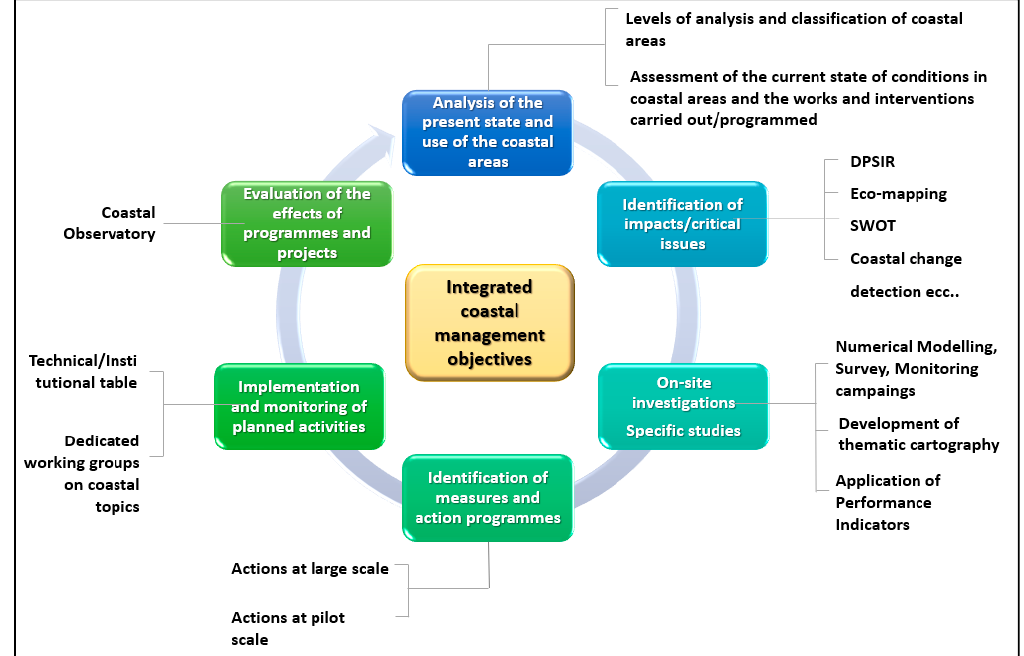
Figure 2. Conceptual outline of coastal management approach.